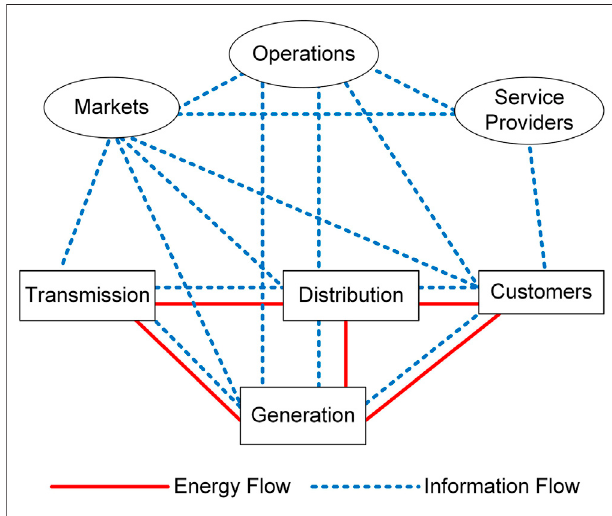
FIGURE 1 | Conceptual model of a smart